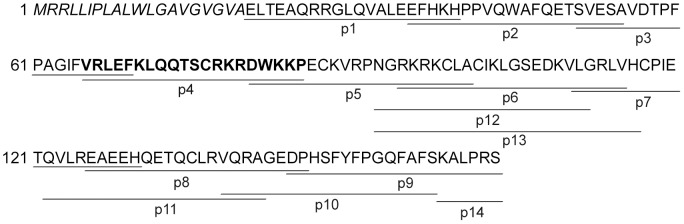
Overlapping peptides (p1-p14) are underlined in the chemerin sequence.The N-terminal signal peptide is indicated by italics. Peptide 4 is shown in bold.